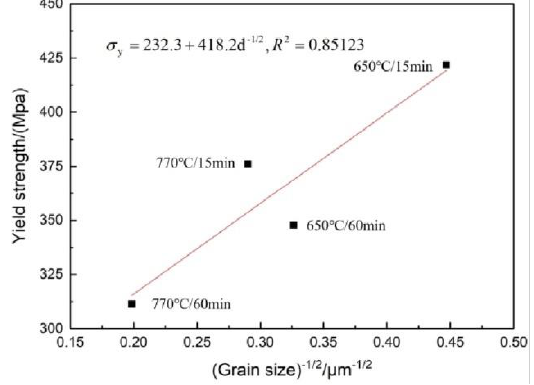
Figure 14. Least-squares fitting results between yield strength and d−1/2.